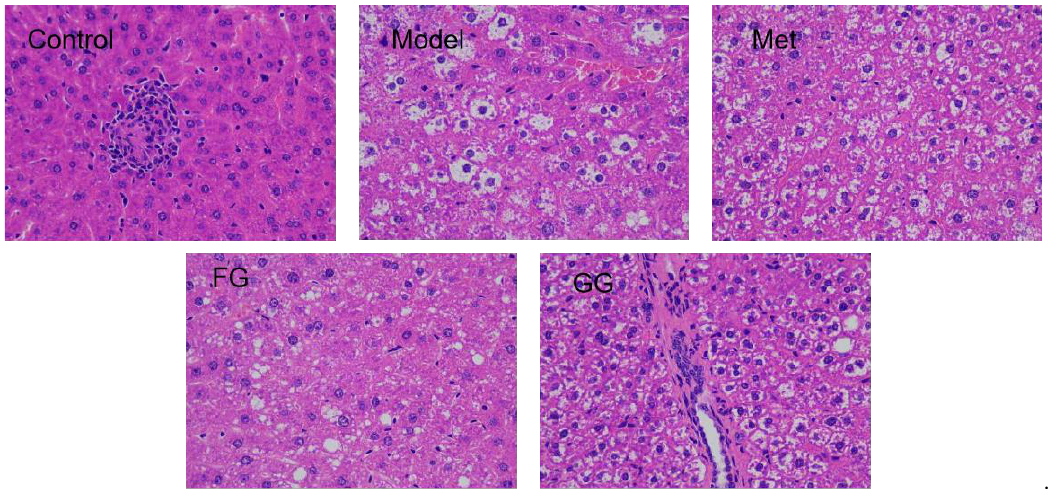
Figure 4. H&E staining of the liver tissue of db/db mice (400× magnification).